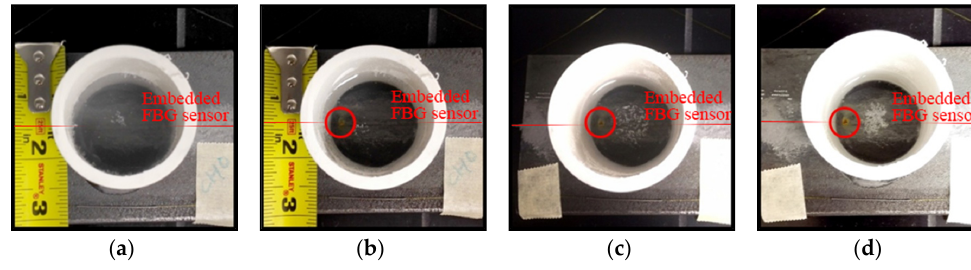
Figure 18. Visual inspections of Sample #7. ( a ) Day 1; ( b ) Day 2; ( c ) Day 3; ( d ) Day 6.